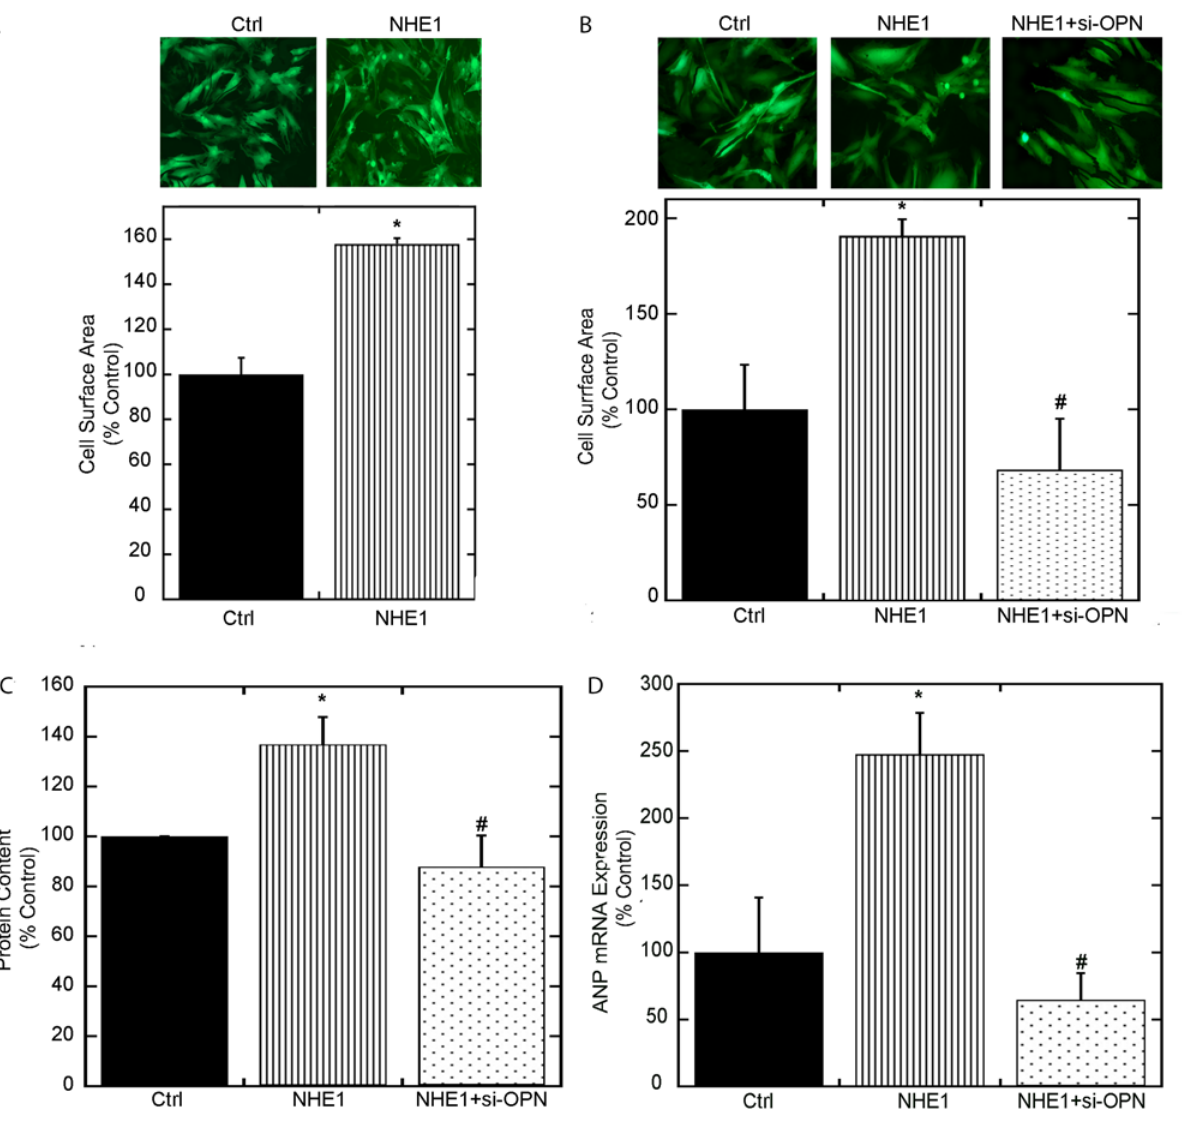
Fig 2. OPN contributes to NHE1-induced cardiomyocyte-hypertrophy. A: upper panel, representative fluorescence microscopy images of NRVMs infected with GFP (control) or active NHE1 adenovirus 24 hours post infection; lower panel, cell surface area of at least 50 – 70 infected NRVMs from 4 – 6 individual dishes were measured to represent 3 – 4 experiments, results expressed as % of control (GFP) ± %SEM. B: Upper panel, representative fluorescence microscopy images of H9c2 cardiomyocytes infected with adenoviruses containing GFP (control) or active NHE1 in the presence and absence of siRNA OPN for 24 hours; lower panel, cell surface area of at least 50 – 70 H9c2 cardiomyocytes from 4 – 6 individual dishes were measured to represent 3 – 4 experiments. C: Protein content of H9c2 cardiomyocytes expressed as μ g/10 x 10 6 cell. D: Quantification of ANP mRNA expression in H9c2 cardiomyocytes normalized to β -actin (n = 6 – 7; representative of 4 experiments). Results are expressed as % of control (GFP) ± %SEM. * p < 0.05 vs. control, # vs.